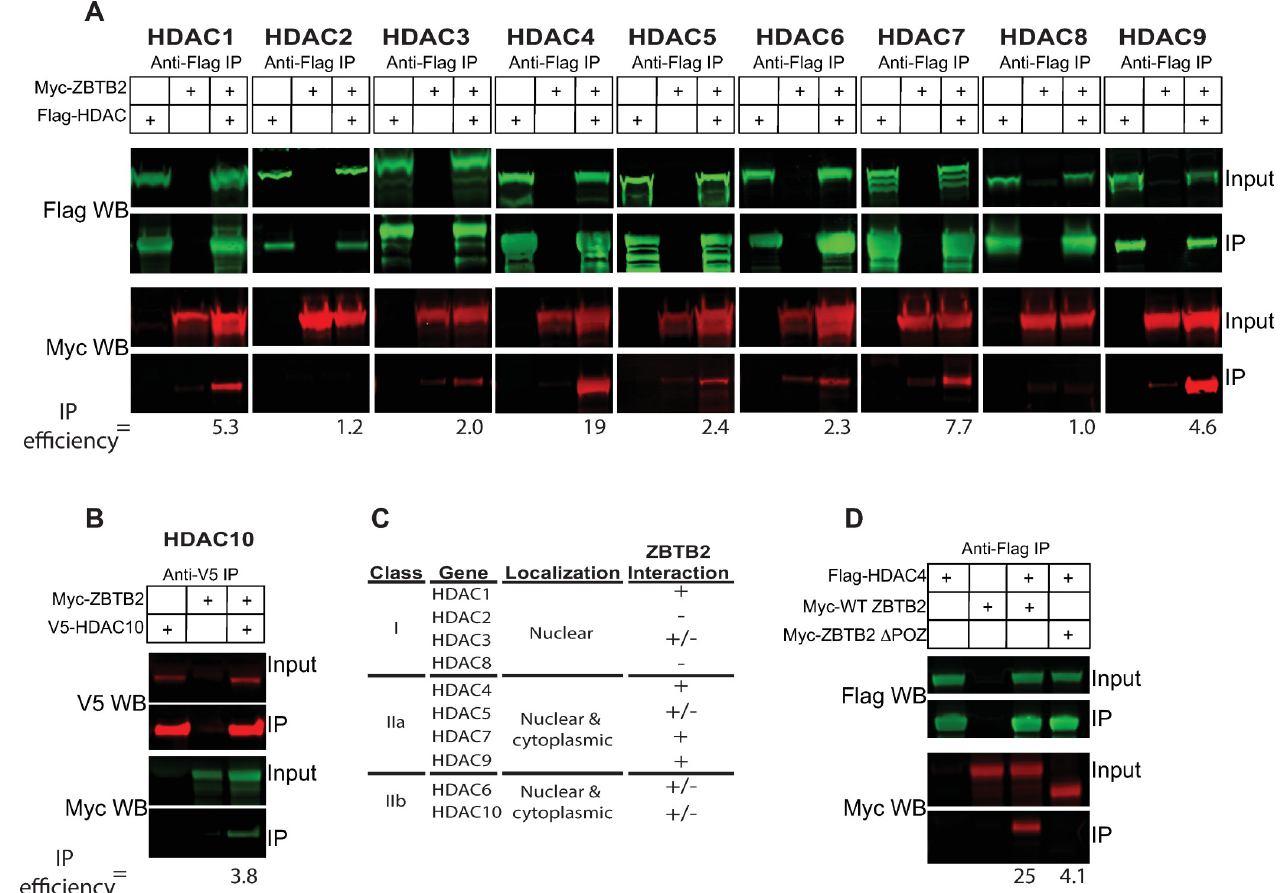
Fig 7. ZBTB2 POZ domain interacts with HDACs. HEK293 cells (1X10 7 ) were transfected with expression plasmids encoding the epitope tagged forms of the indicated proteins. 48 h post-transfection, cells were lysed and epitope tagged proteins were immunoprecipitated (IP) with anti-Flag beads, separated by SDS-PAGE and analyzed by western blotting (WB) using the indicated antibodies as described in Materials and Methods. (A) Co-immunoprecipitation of Myc-ZBTB2 and Flag-tagged HDACs 1–9 or (B) V5 tagged HDAC10. (C) Summary of ZBTB2 and cellular HDAC interactions. Interaction (+) was defined as having an IP efficiency greater than 4.5, weak interaction (+/-) as less than 4.5 and no interaction (-) as less than 1.5. (D) Co-immunoprecipitation assays of Flag-HDAC4 and Myc-WT ZBTB2 or Myc- Δ POZ ZBTB2. IP efficiency is the ratio of % starting material immunoprecipitated by HDAC verses the % starting material precipitated with no HDAC (e.g. ratio of lane 3:lane 2 in A and